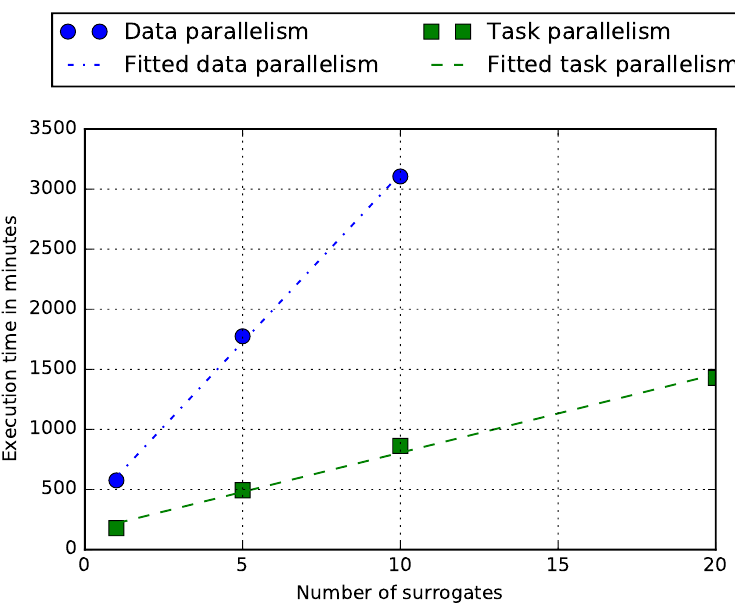
Figure 4. Data and Task Parallelism total execution time per number of surrogate signals. Point marks show numerical results in minutes. Lines show data fitted by the linear square